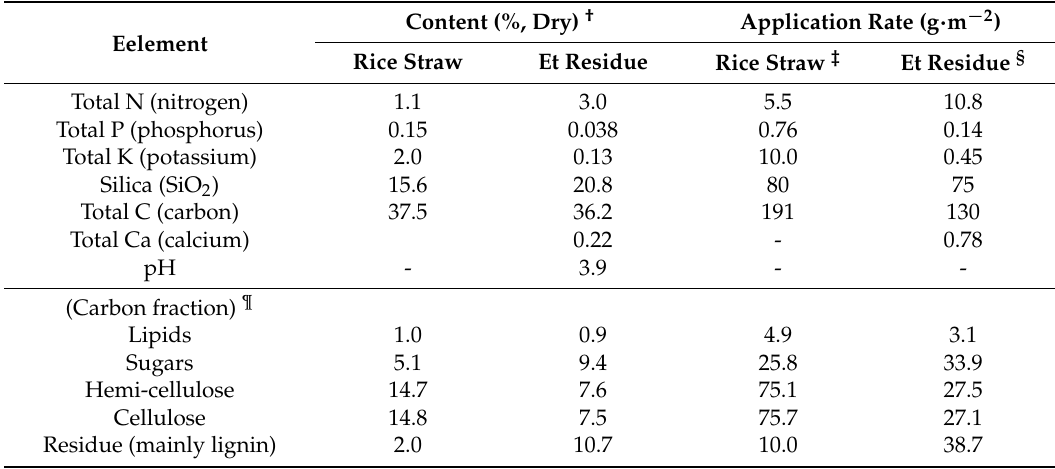
Table 1. Contents of elements and carbon fractions in rice straw and bio-ethanol production residue and their application rates to each experimental plot (average for four years). Content (%, Dry) Eelement